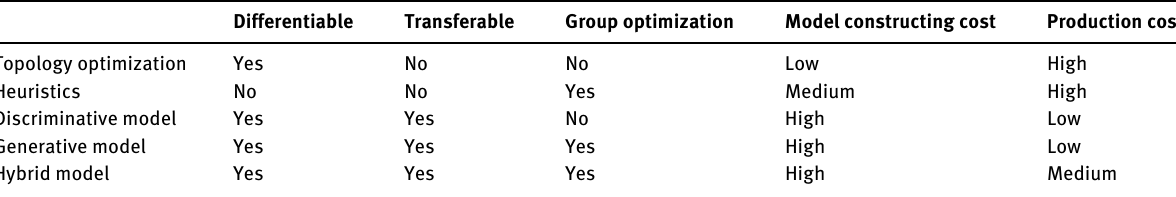
Table 1: Comparison of inverse design